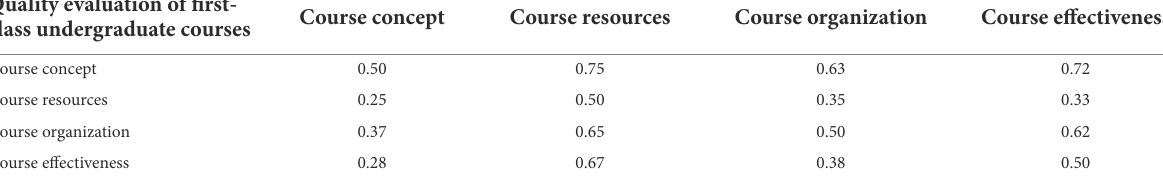
TABLE 3 Score of the importance of each indicator in the first-class undergraduate course quality evaluation criterion layer. Quality evaluation of first- class undergraduate courses